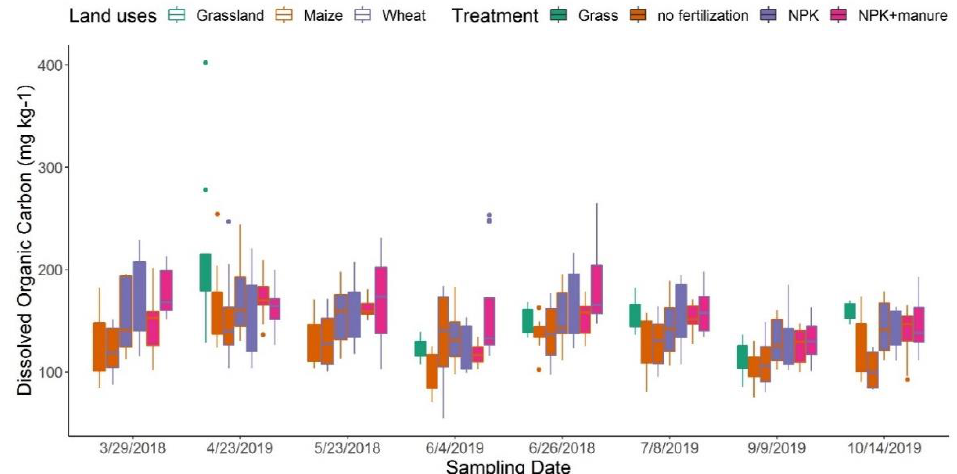
Figure 2. Dissolved organic carbon (DOC) concentrations in cropland and grassland plots under different treatments and across crop cover. Total sample size was n = 648, with n = 12 for each treatment and crop cover. Dots indicate outliers. NPK: nitrogen, phosphorus, potassium.